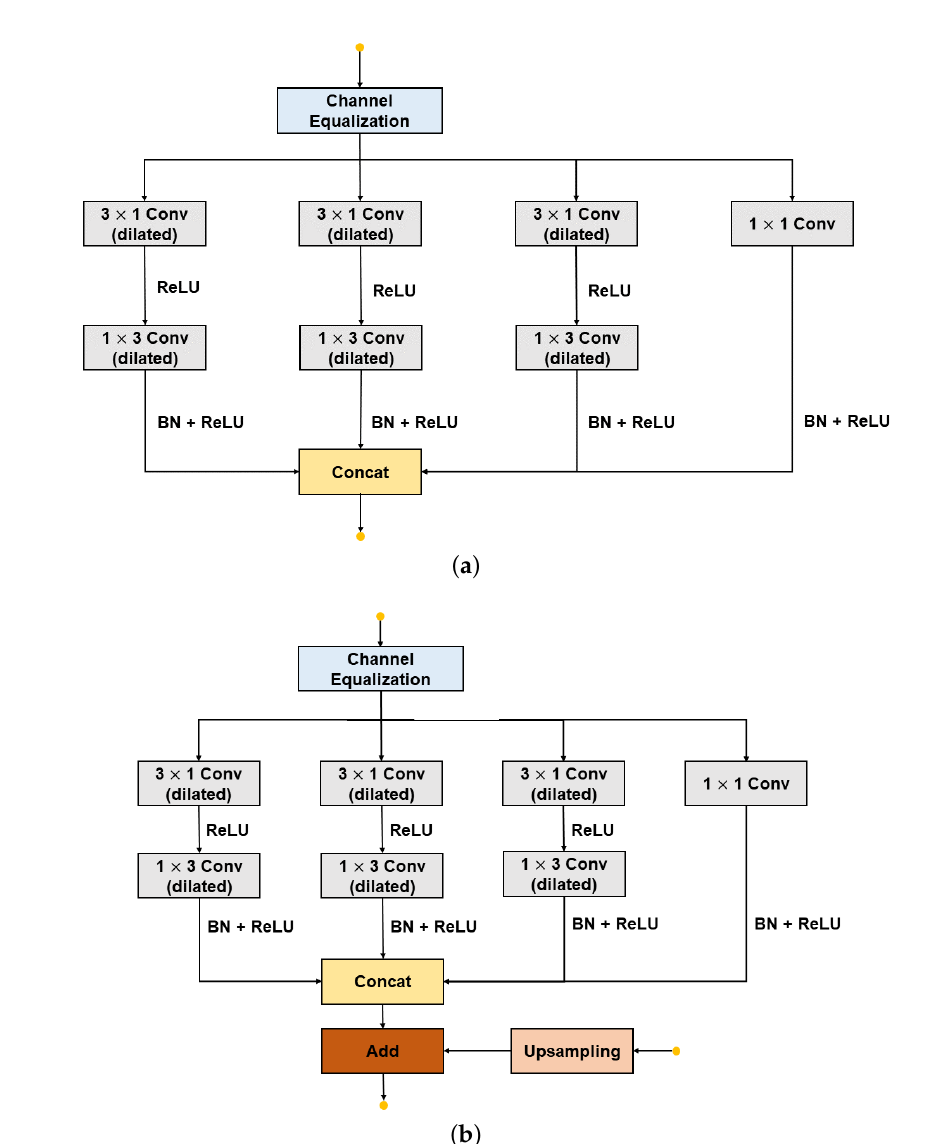
Figure 4. Semantic gap compensation block. Among them, ( a ) is for the current layer, and ( b ) is employed for the fusion between different stages. Notation: “Conv” is convolutional operation. “BN” denotes the batch normalization. “Dilated” means dilated